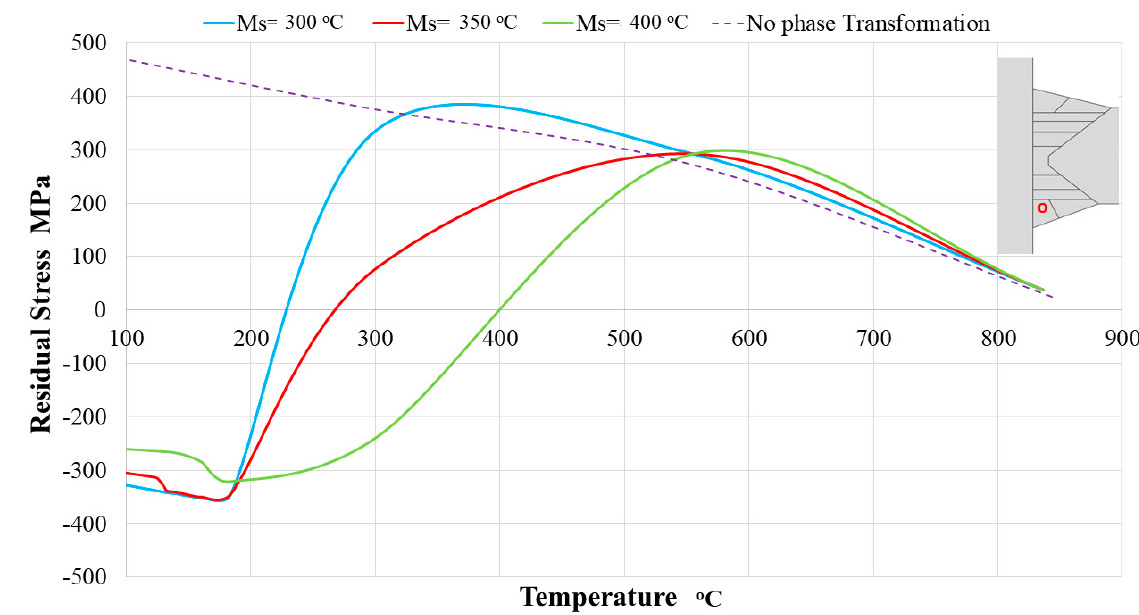
Figure 13. Stress accumulation at the last (10th) bead.